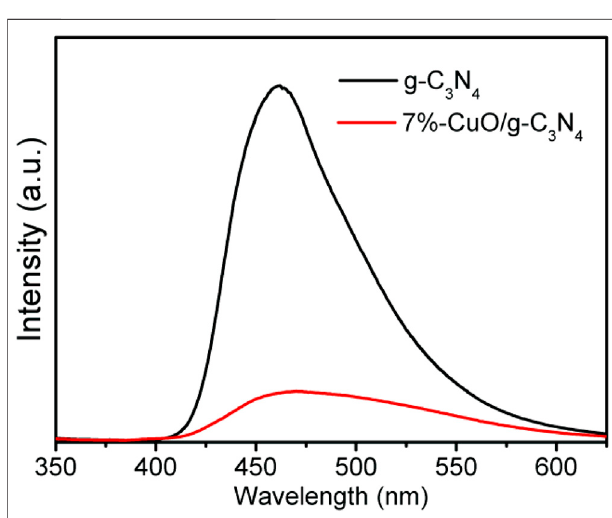
FIGURE 9 | Photoluminescense (PL) spectra of g-C 3 N 4 and 7%-CuO/ g-C 3 N 4 samples.